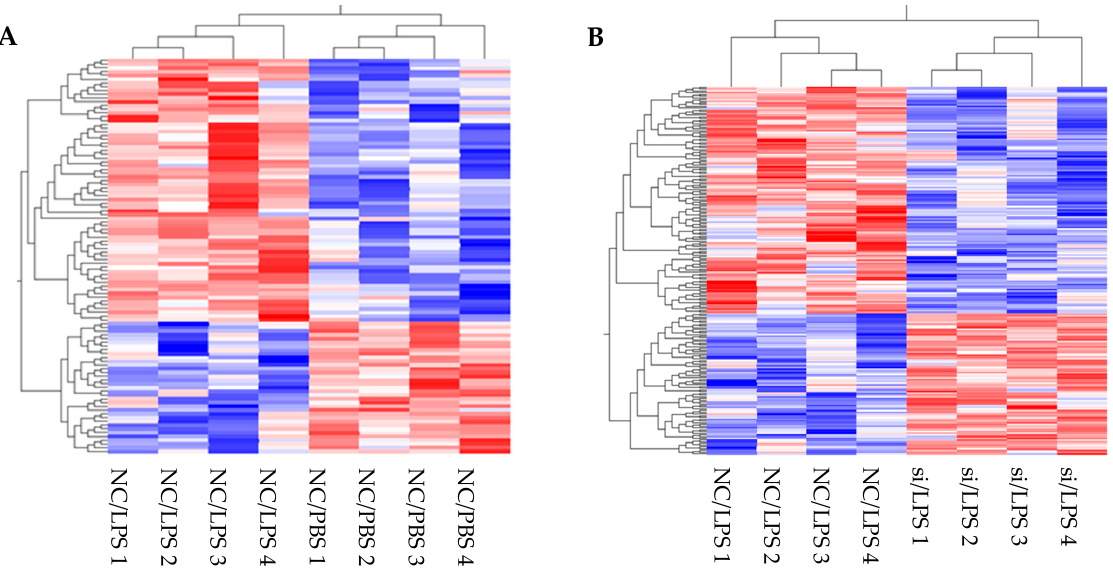
Figure 4. Transcriptomic analysis of HLMVECs with LPS challenge. Heatmap represents the transcriptomic analysis of differentially expressed genes in HLMVECs after LPS stimulation. ( A ): Negative control siRNA (NC)/LPS vs. NC/PBS, and ( B ): DPP4 siRNA (siRNA)/LPS vs NC/LPS. Table 3. Enrichment analysis of transcriptomic data after LPS (NC/PBS vs. NC/LPS). KEGG path- way: NC/PBS vs. NC/LPS.